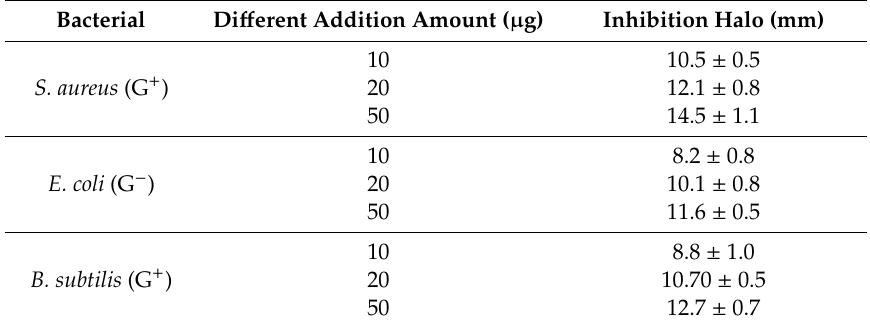
Figure 12. Inhibition of ( a ) S. aureus , ( b ) E. coli , and ( c ) B. subtilis with di ff erent concentrations (1, stroke-physiological saline solution; 2, 10 µ g; 3, 20 µ g; 4, 50 µ g) of lectin. Inhibition of ( d ) S. aureus , ( e ) E. coli , and ( f ) B. subtilis with di ff erent concentrations (1, stroke-physiological saline solution; 2, 10 µ g; 3, 20 µ g; 4, 50 µ g) of phenol. Table 6. The bacteriostatic circle diameter of bacteria with di ff erent concentrations of lectin.